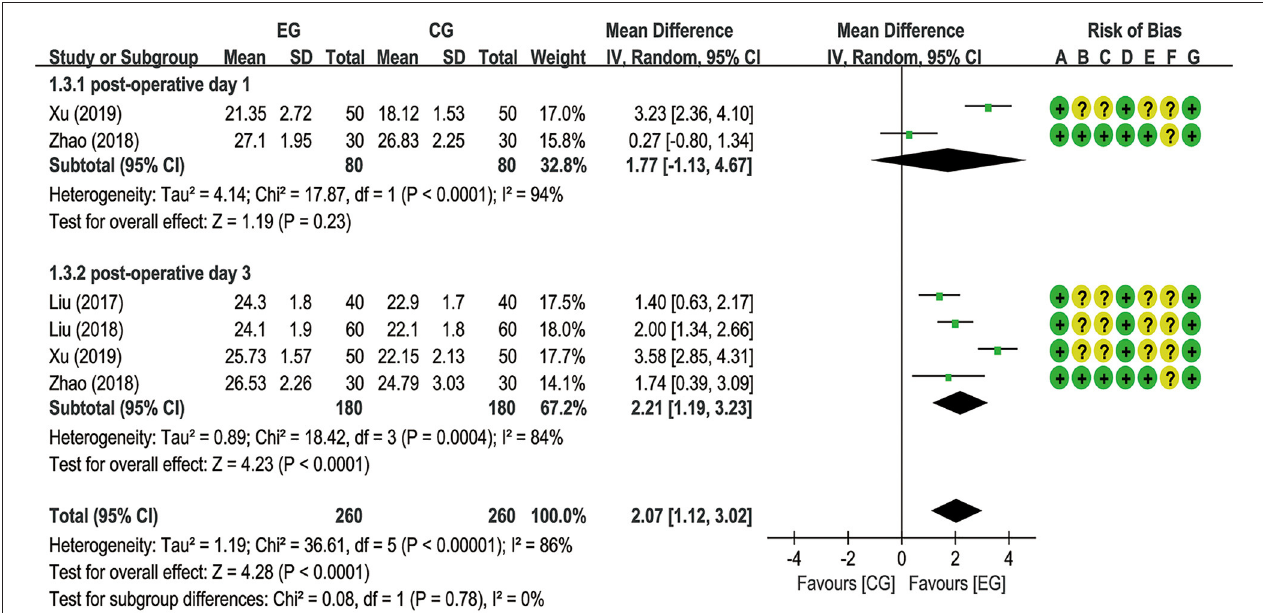
FIGURE 4 | Meta-analysis and forest plot and for the Mini-Mental State Examination (MMSE) scores at different periods.